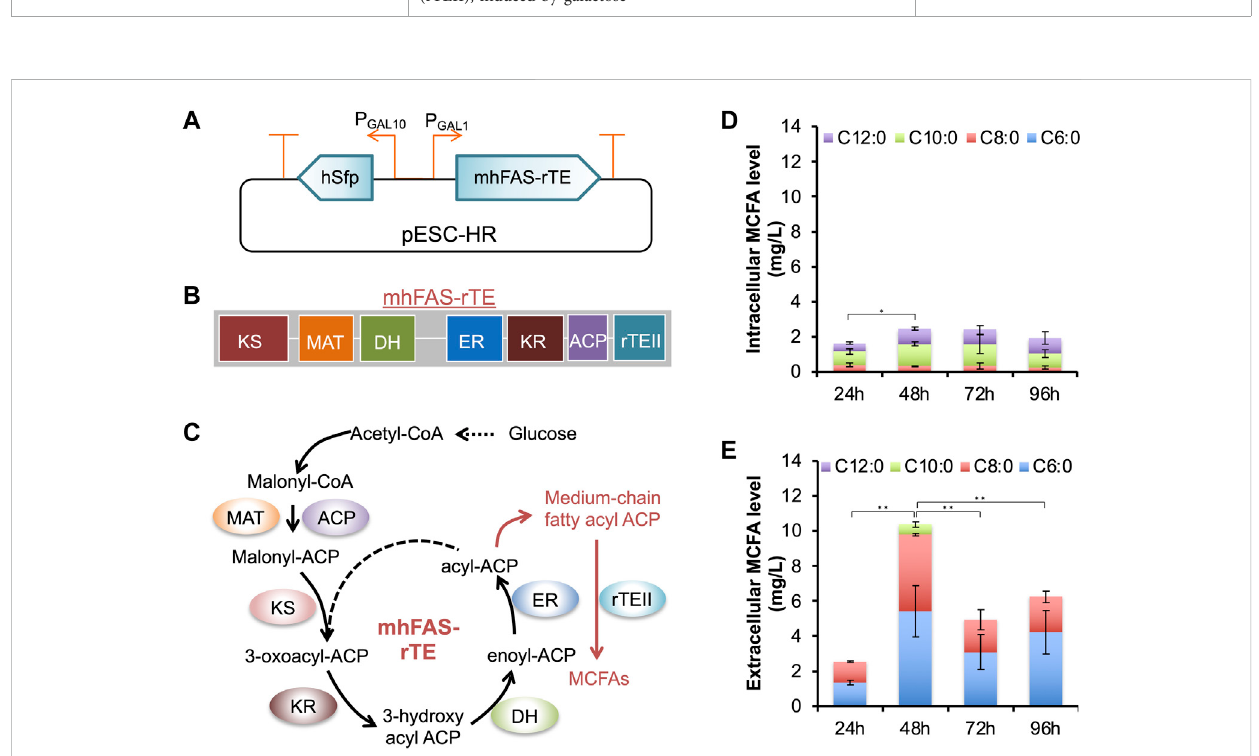
FIGURE 2 Plasmid-based inducible expression of an MCFA biosynthetic pathway and the analysis of MCFAs produced by the engineered strain CLPY03. (A) . Schematic of the recombinant plasmid pESC-HR harboring the MCFA biosynthetic pathway under the control of galactose-inducible promoters (P GAL1 andP GAL10 ). (B) .OrganizationofmhFAS-rTEdomains. (C) .SchematicoftheMCFAbiosyntheticpathway. (D) .MeasurementoftheintracellularMCFAs. (E) . The time-course production level of MCFAs secreted into the medium. The data was obtained from at least three independent experiments. *, p